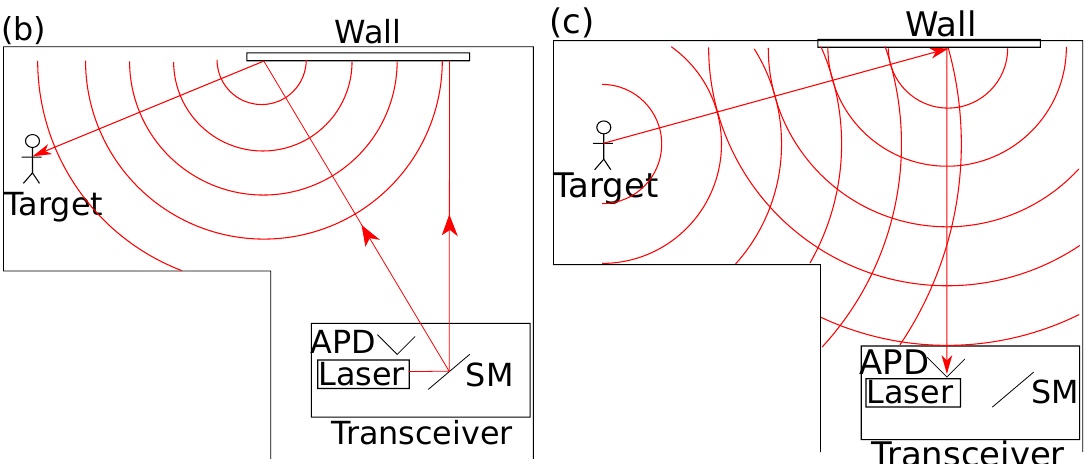
Figure 1. ( a ) Schematic (not-to-scale) representation of the setup used for this experiment. The wall is a cardboard screen covered with white paper. The target moves out of the direct line-of-sight along the path indicated. ( b ) Light path from transceiver to target. ( c ) Light path from target to APD. SM, scanning mirror.